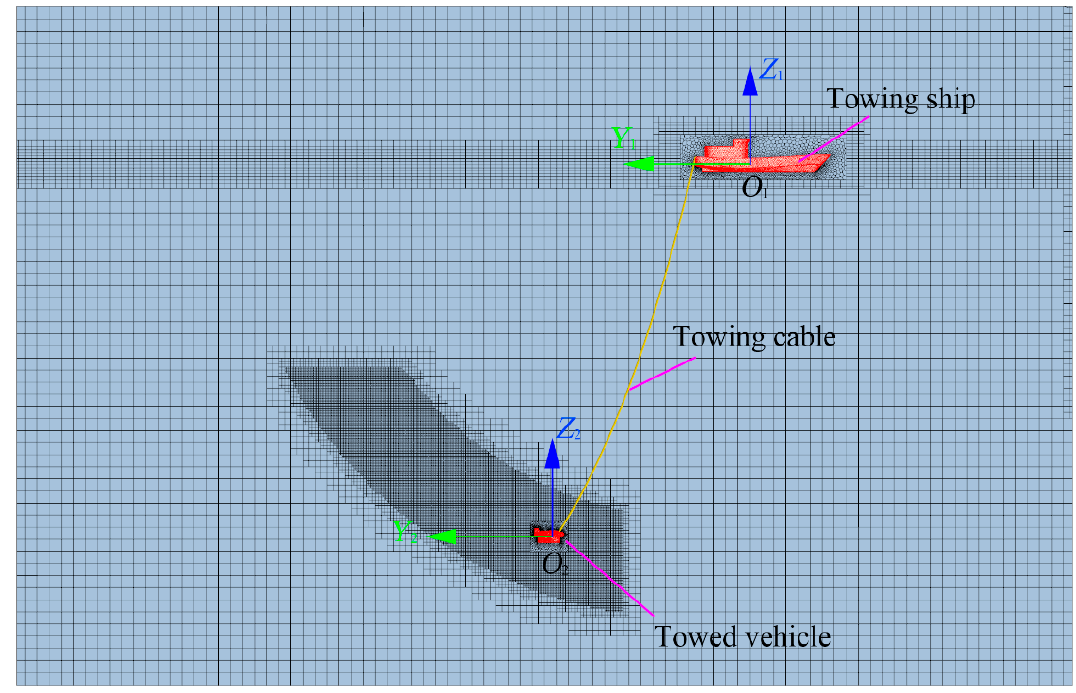
Figure 4. Longitudinal cutaway view of the mesh.